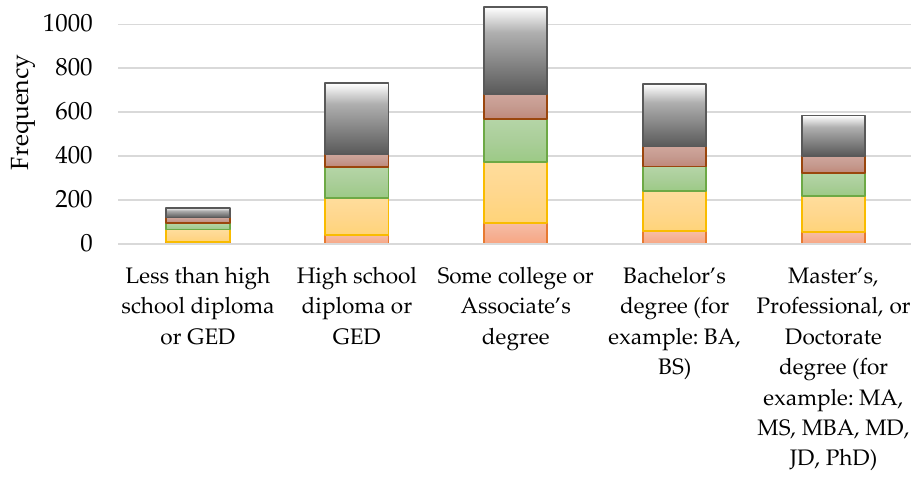
Figure 5. Household respondents’ highest earned degree per climate zone (total n = 3288).